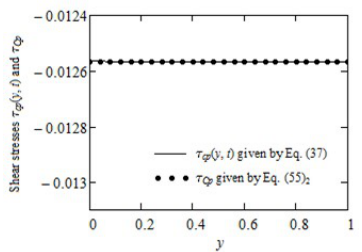
Figure 3. Comparison between the shear stresses τ cp ( y , t ) and τ Cp for Re = 100, We = 0.3, α = 0.4, ω = 0.001 and t = 10